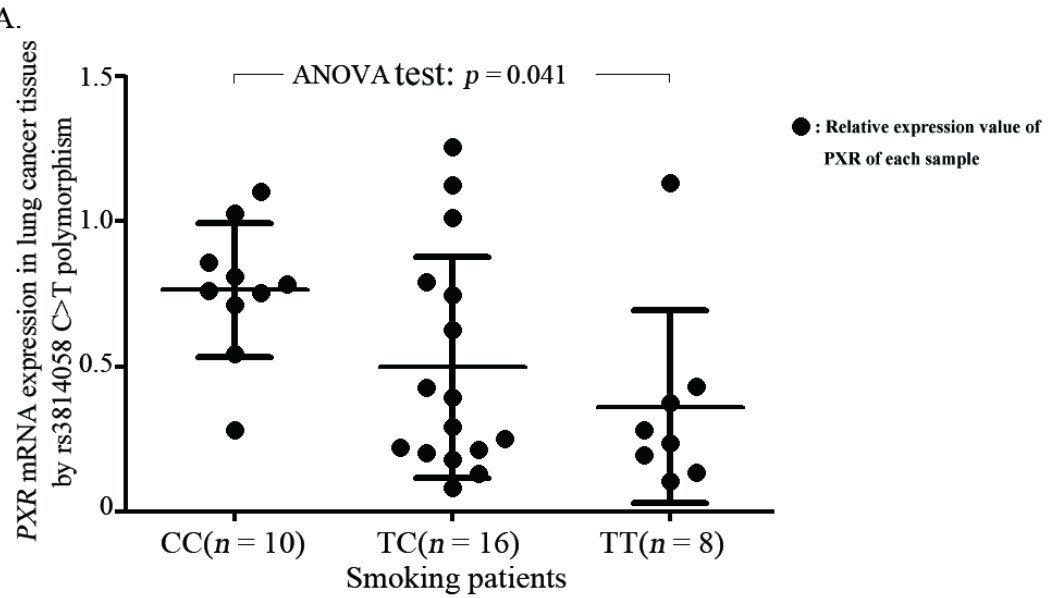
Figure 1. The difference of relative mRNA levels of PXR in lung cancer tissues by the rs3814058C>T genotypes with regard to smoking status. ( A ) In cancer tissues from smoking patients including current and former smokers; and ( B ) In cancer tissues from non-smoking patients; the differences of mRNA levels in tumor tissues with different genotypes were assessed by the One-way ANOVA